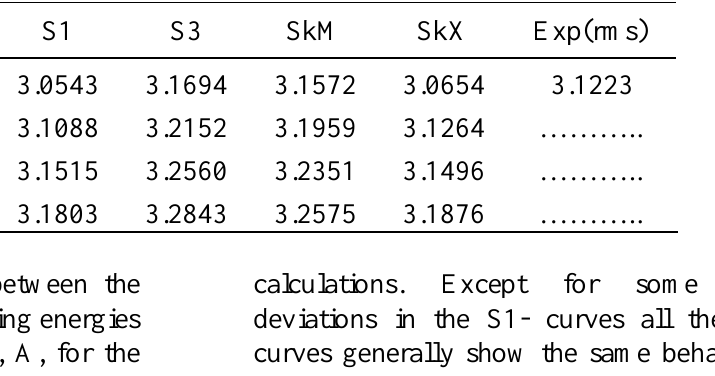
Fig. 7: The RMS- values of: Si-isotopes, for different Skyrme interaction parameters. The rms charge radii for 28 Si and 40 Si to (3.0543) and (3.1803) by S1 as shown in decrease from (3.1853) and (3.2785) by SkM* Table 2: The calculated values of nuclear charge rms radii compared with experimental values taken from Ref.